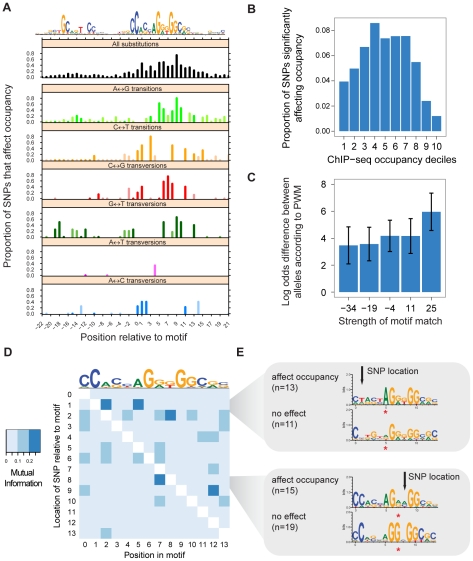
Sequence context buffers effect of polymorphism on occupancy.(A) Average effect of SNPs on occupancy across 1,368 different sites, broken down by genotypes (panels) and position (x-axis) relative to the canonical motif (top). Y-axis, proportion of sites where a change is associated with differences in occupancy (FDR 1%). In comparison, 1% of changes observed outside this 44 bp region affected binding (Table S4). Only changes observed at least 3 sites are considered; in particular, few A–T transversions were observed due to the GC-rich nature of the motif. (B) SNPs at the weakest and strongest sites are less likely to affect occupancy. X-axis, decile of ChIP-seq signal for the heterozygote genotype according to the regression model; each decile represents 583 sites. Y-axis, proportion of sites in at which SNPs are associated with differential occupancy. (C) SNPs affecting occupancy despite stronger motif contexts involve more severe perturbations. X-axis, log-odds score of motif match, stronger matches at the right, label represents lower limit of bin. Y-axis, magnitude of perturbation, represented by the difference in log-odds scores between the two alleles. Error bars indicate standard deviation. In contrast, SNPs not affecting occupancy show no such trend (Table S9). (D) Each cell measures the mutual information between the base pair at positions in the core motif (x-axis) and whether a SNP at another position in the motif (y-axis) affects occupancy (FDR 5%). (E) Sequence context at sites with SNPs (arrows) at position 1 (above), 6 (below), divided by whether the SNP affected occupancy. Red stars highlight significant sequence differences (q<0.05, see Materials and Methods) between buffered and unbuffered sites at positions with elevated mutual information along the x-axis in (D).